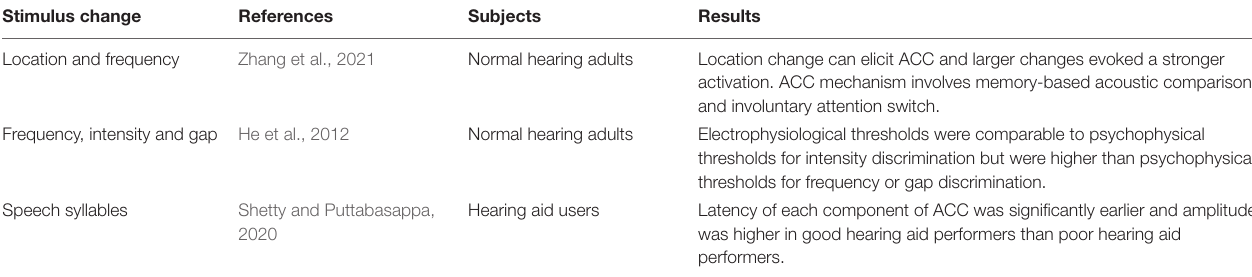
TABLE 6 | Summary of the findings in other ACC